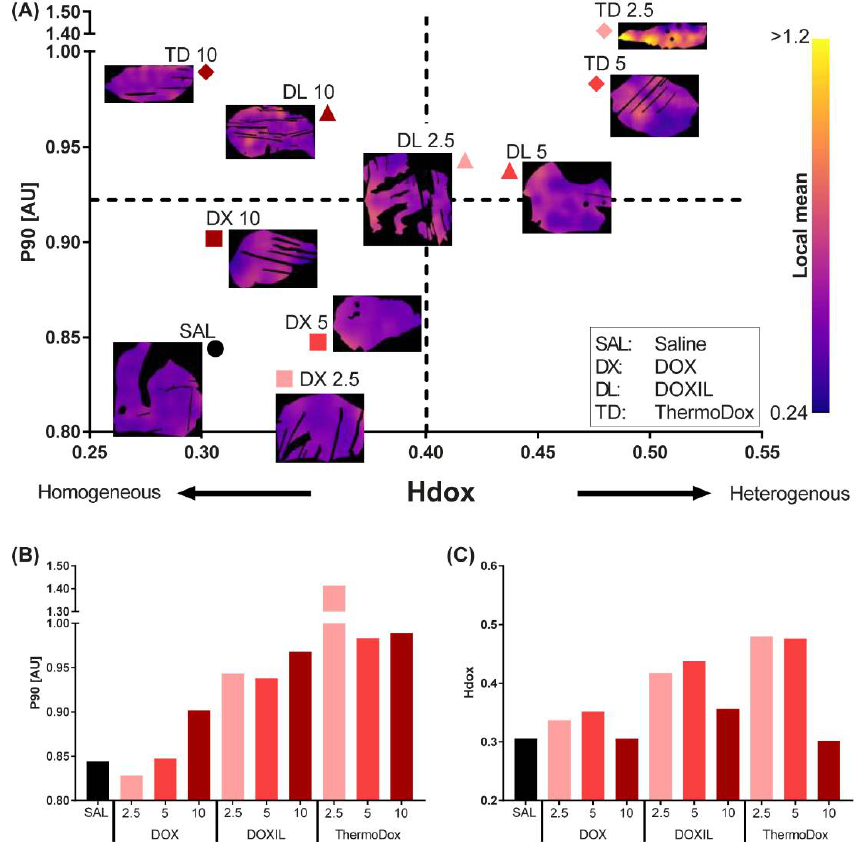
Figure 3 . The 90th percentile of the doxorubicin concentration (P90) and the doxorubicin heterogeneity parameter (Hdox) over the whole tumor. Tumors treated with saline (SAL), DOX (DX), DOXIL (DL), and ThermoDox (TD) at 2.5, 5, and 10 mg/kg. The P90 ( A and B ) and the Hdox ( A and C ) were calculated over the whole tumor.